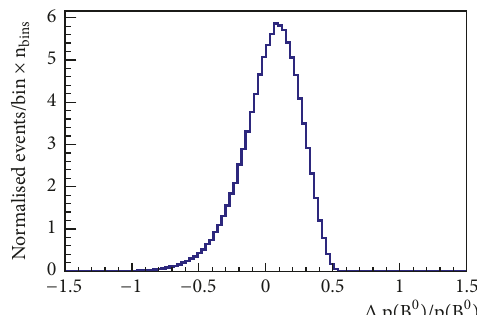
Figure 8: Relative resolution on the 𝐵 momentum magnitude for 𝐵 󳨀→ 𝐷 ∗+ 𝜏 − (󳨀→ 𝜇 − ]